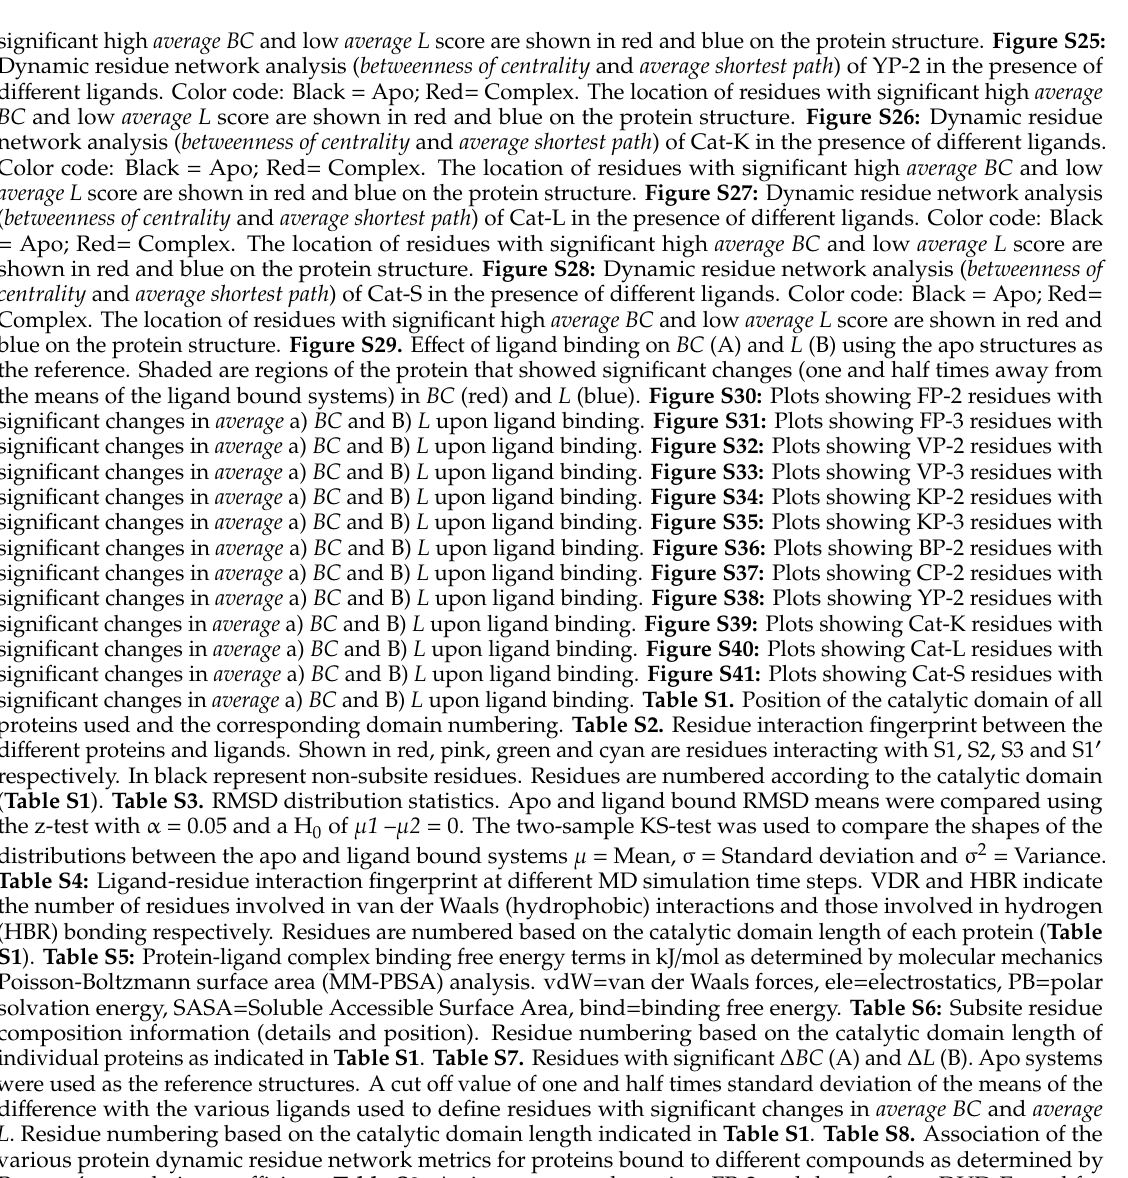
( Table S1 ). Table S3. RMSD distribution statistics. Apo and ligand bound RMSD means were compared using the z-test with α = 0.05 and a H 0 of µ 1 – µ 2 = 0. The two-sample KS-test was used to compare the shapes of the Table S4: Ligand-residue interaction fingerprint at di ff erent MD simulation time steps. VDR and HBR indicate the number of residues involved in van der Waals (hydrophobic) interactions and those involved in hydrogen (HBR) bonding respectively. Residues are numbered based on the catalytic domain length of each protein ( Table S1 ). Table S5: Protein-ligand complex binding free energy terms in kJ / mol as determined by molecular mechanics Poisson-Boltzmann surface area (MM-PBSA) analysis. vdW = van der Waals forces, ele = electrostatics, PB = polar solvation energy, SASA = Soluble Accessible Surface Area, bind = binding free energy. Table S6: Subsite residue composition information (details and position). Residue numbering based on the catalytic domain length of individual proteins as indicated in Table S1 . Table S7. Residues with significant ∆ BC (A) and ∆ L (B). Apo systems were used as the reference structures. A cut o ff value of one and half times standard deviation of the means of the di ff erence with the various ligands used to define residues with significant changes in average BC and average L . Residue numbering based on the catalytic domain length indicated in Table S1 . Table S8. Association of the various protein dynamic residue network metrics for proteins bound to di ff erent compounds as determined by Pearson’s correlation coe ffi cient. Table S9. Active compounds against FP-2 and decoys from DUD-E used for docking protocol